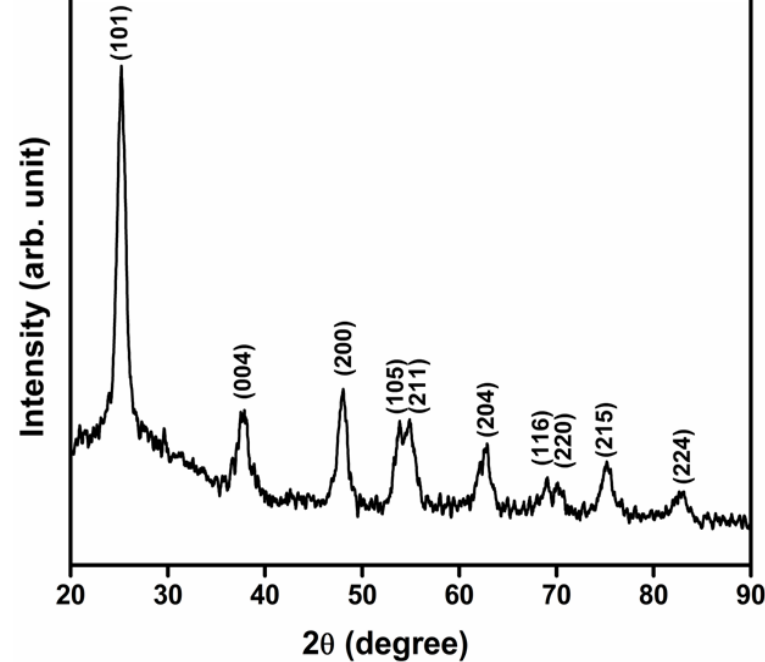
Figure 1. X-ray diffraction analysis (XRD) pattern of titanium dioxide (TiO 2 ) nanoparticles calcined at 500 °C.